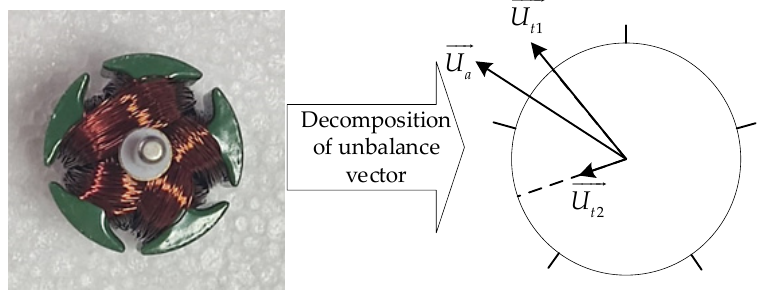
Figure 7. Milling force component of the five-slot micromotor armature.